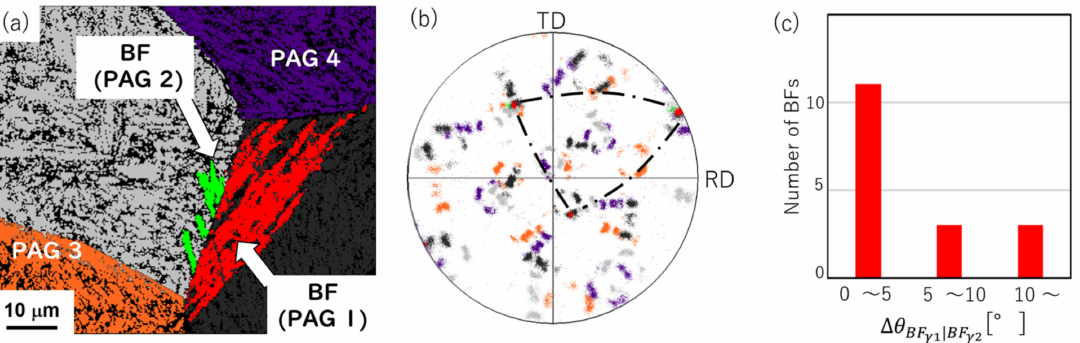
Figure 6. ( a ) Highlighted IQ map, and ( b ) the corresponding (0 0 1) α pole figure highlighted following by ( a ). ( c ) The distribution of the misorientation angles between the BFs across the